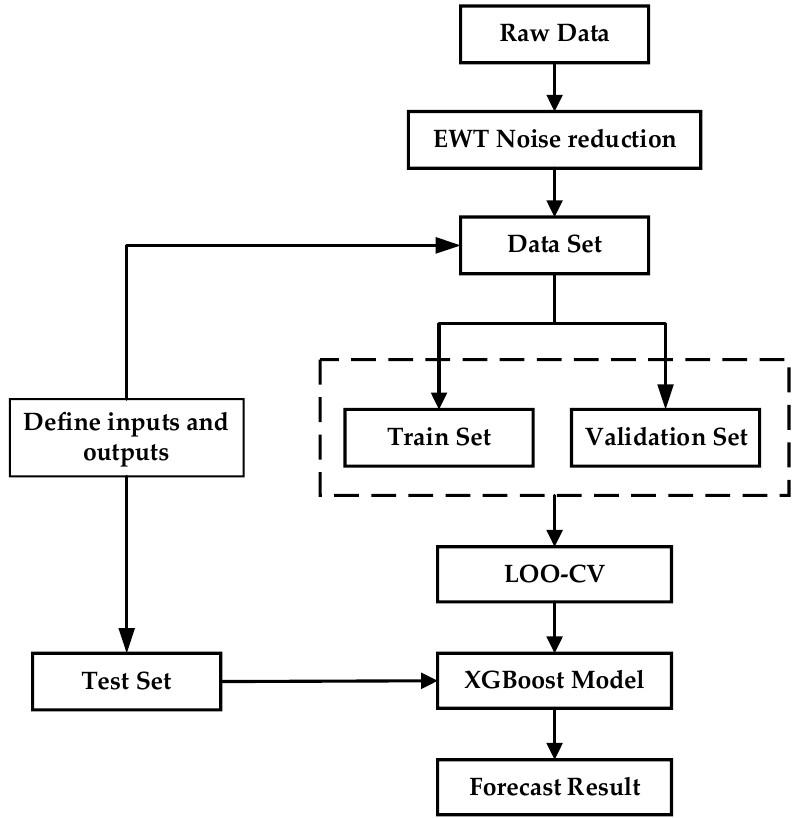
Figure 3. EWT – XGBoost prediction model flowchart. Figure 3. EWT–XGBoost prediction model